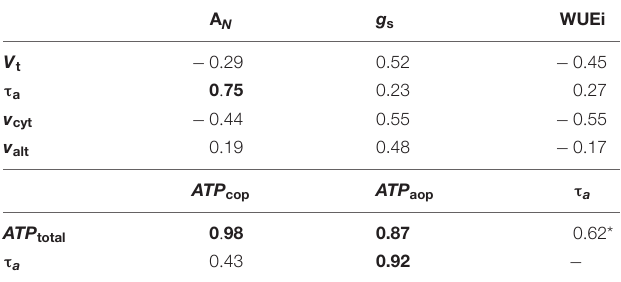
0.92 − Fold change values were log10 transformed and then used for the Pearson correlations. The same plants were used for all analyses, thus allowing 10-point correlations using the 4–6 replicates and the 10 species analyzed. The value in bold indicates a statistically significant Pearson coefficient with p value < 0.05. *Denotes a p-value = 0.058.